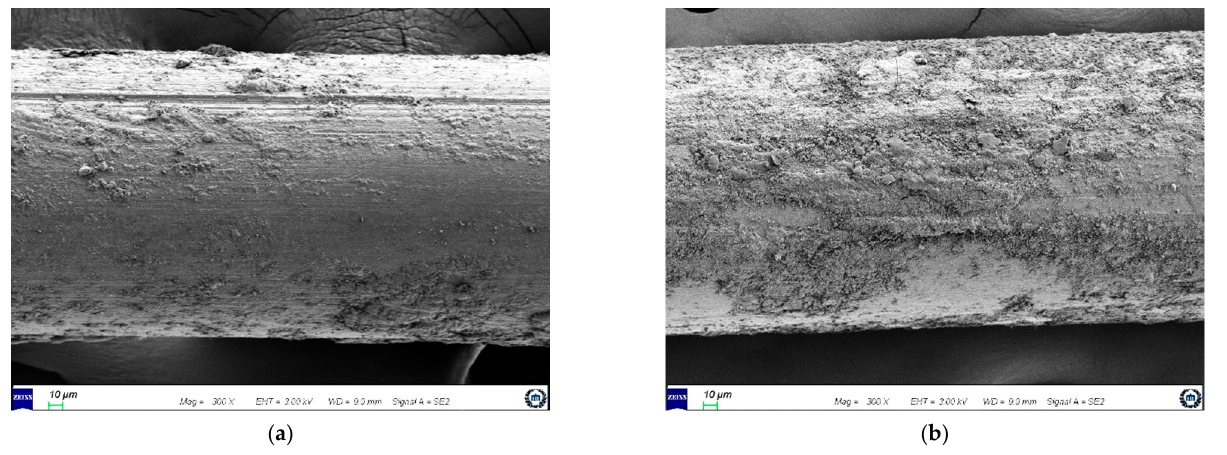
Figure 9. Surface condition of SSF after high-rate tensile test (SEM image): ( a ) case with scratched on the surface; ( b ) case with mortar attached on the surface.